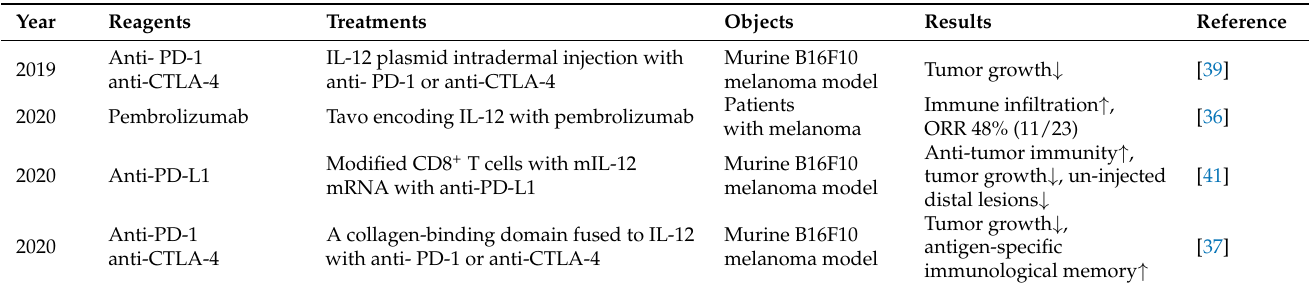
Table 2. IL-12 in combination with ICI for therapy of